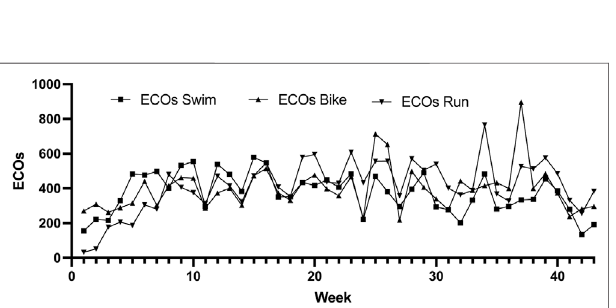
FIGURE 2 | Weekly training load per